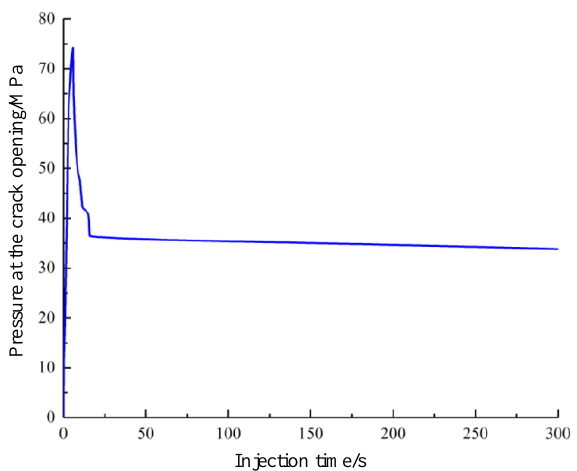
Figure 7. The relationship between the pressure at the injection point and the injection time.